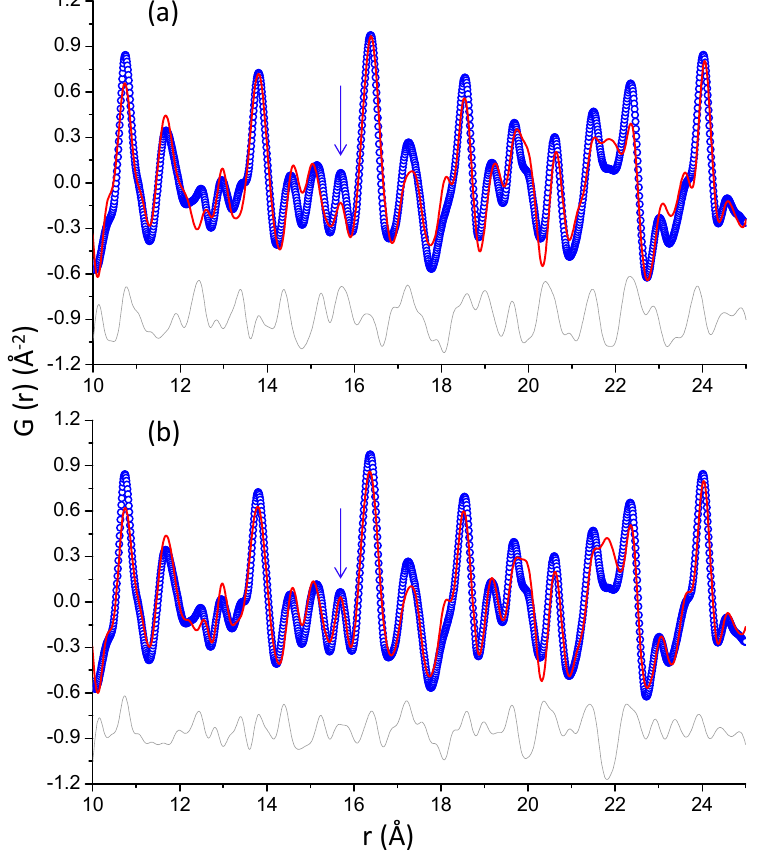
Figure 4. Experimental (blue circles) and fitted (red solid line) PDF patterns for Ca 3 SiO 5 w/s = 0.80 paste in the 10–25 Å r-range. ( a ) Fit including only portlandite and alite phases, R W = 36.3% and ( b ) Fit including portlandite, alite, and clinotobermorite T3_14sc phases, R W = 28.5%. Difference curves are shown as grey lines.